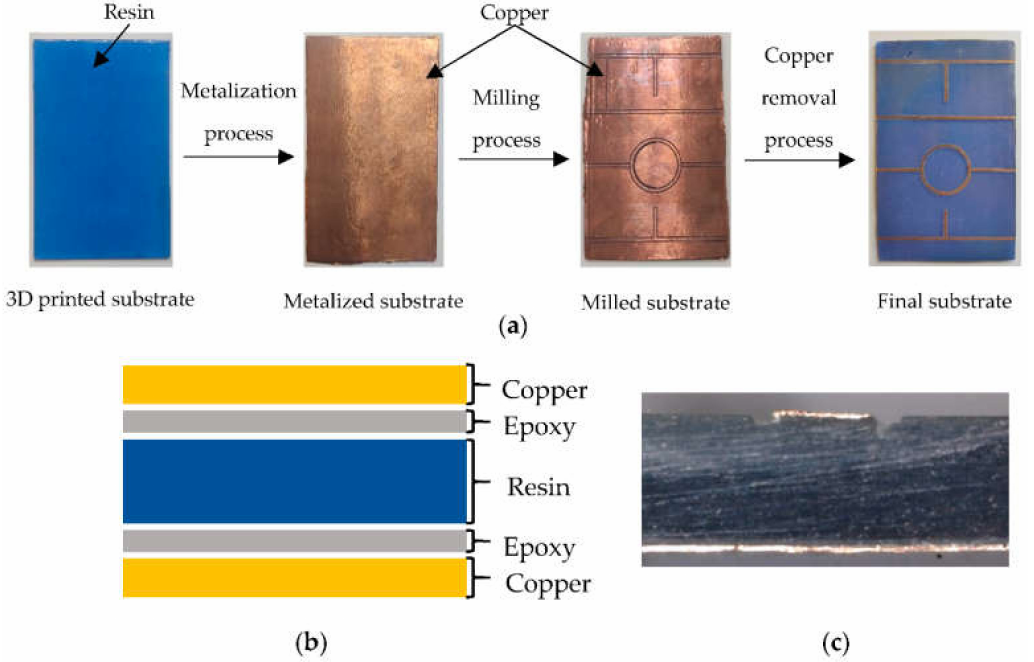
Figure 2. Printed circuit board manufacturing process with glued copper layer: ( a ) step by step description; ( b ) cross-section of the manufactured substrate; ( c ) transmission line end cross-section.